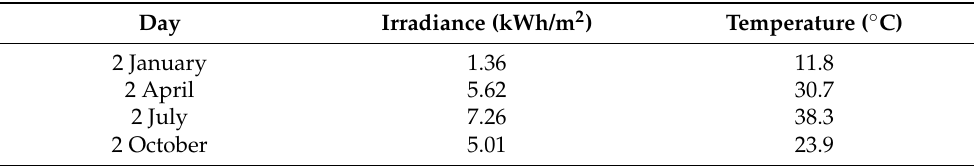
Table 2. Daily average solar irradiance and ambient temperature from experimental measurement for four selected days through